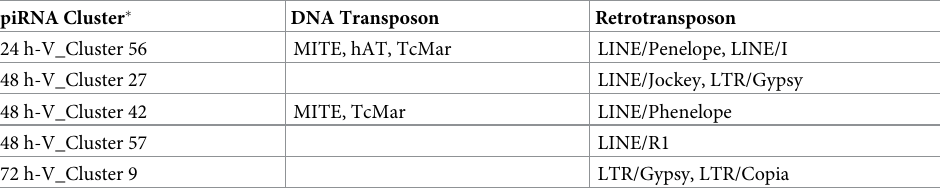
Table 6. Transposable elements targeted by induced piRNA